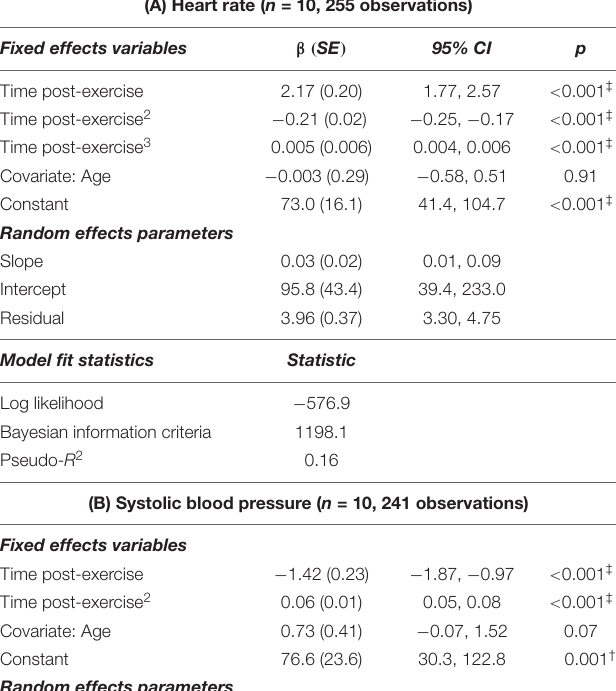
TABLE 2 | Mixed model analysis describing the changes in carotid-femoral pulse wave velocity after acute, high-intensity aerobic exercise ( n = 10, 256 observations).